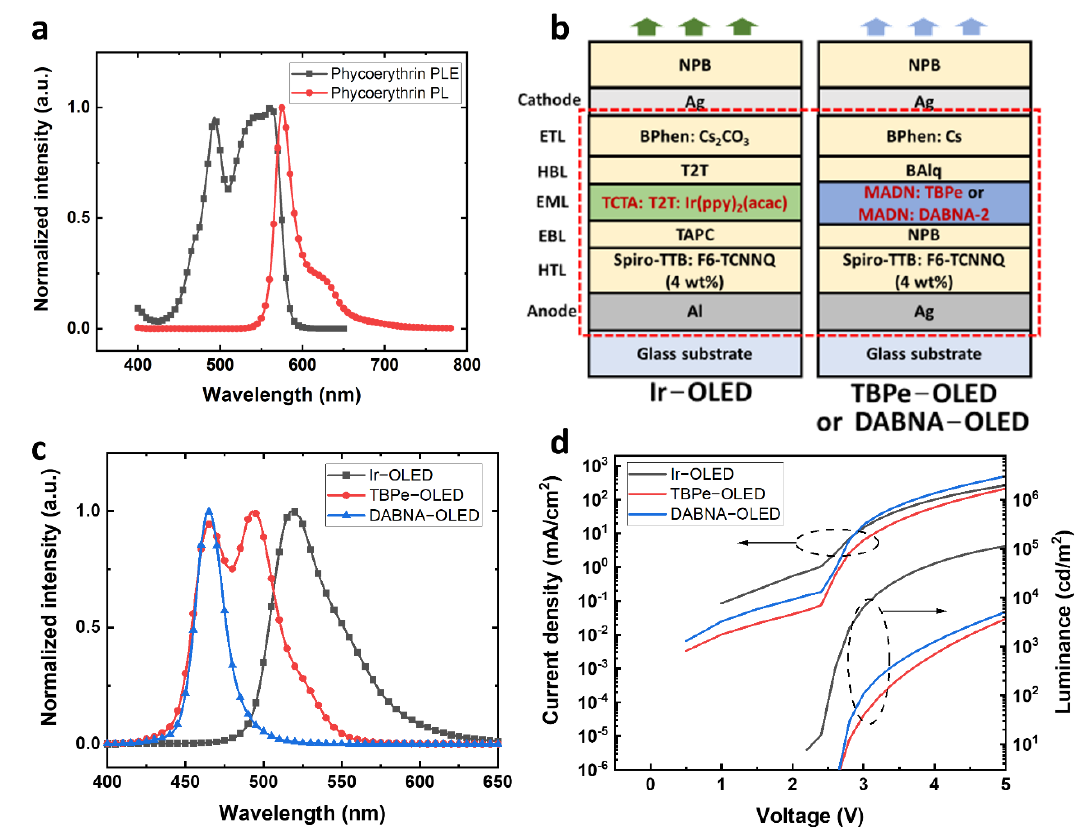
Figure 1. Phycoerythrin (PE) spectra and OLED information. ( a ) Photoluminescence excitation (PLE) and photoluminescence (PL) spectra of PE. ( b ) Device structures of OLEDs based on Ir(ppy) 2 (acac), TBPe, and DABNA-2 emitters. ( c ) Electroluminescence (EL) spectra of Ir − OLED, TBPe − OLED and DABNA − OLED. ( d ) J − V − L characteristics of Ir − OLED, TBPe − OLED and DABNA − OLED.